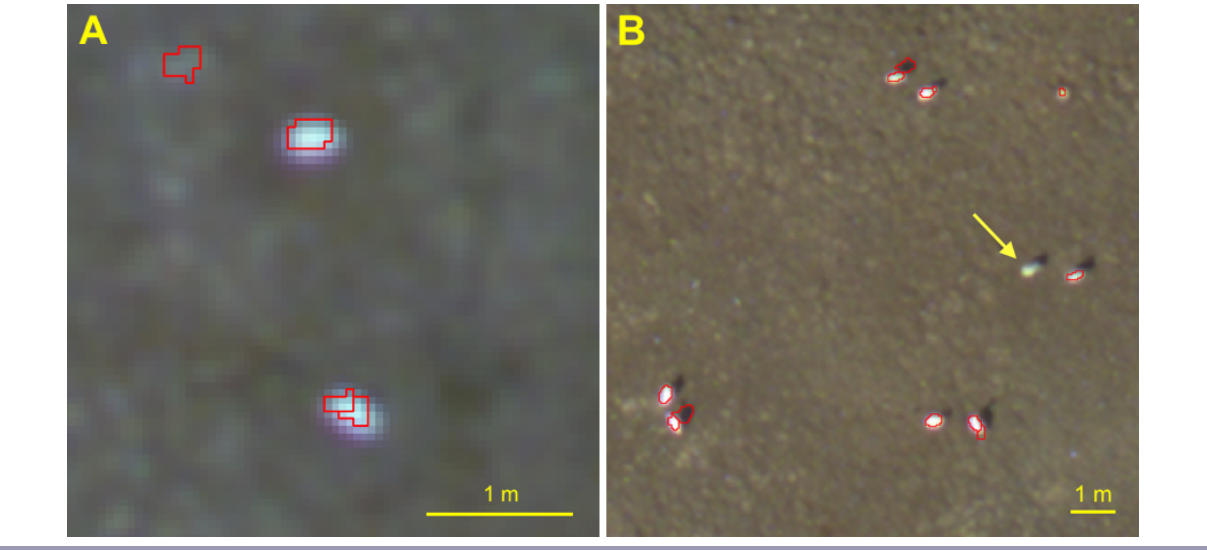
Fig. 3 . Example of an oversegmented bird (A) and an omitted bird (B) among adequately segmented birds and other segmented features in aerial imagery of Canadian Arctic-breeding Lesser Snow Geese ( Chen caerulescens caerulescens